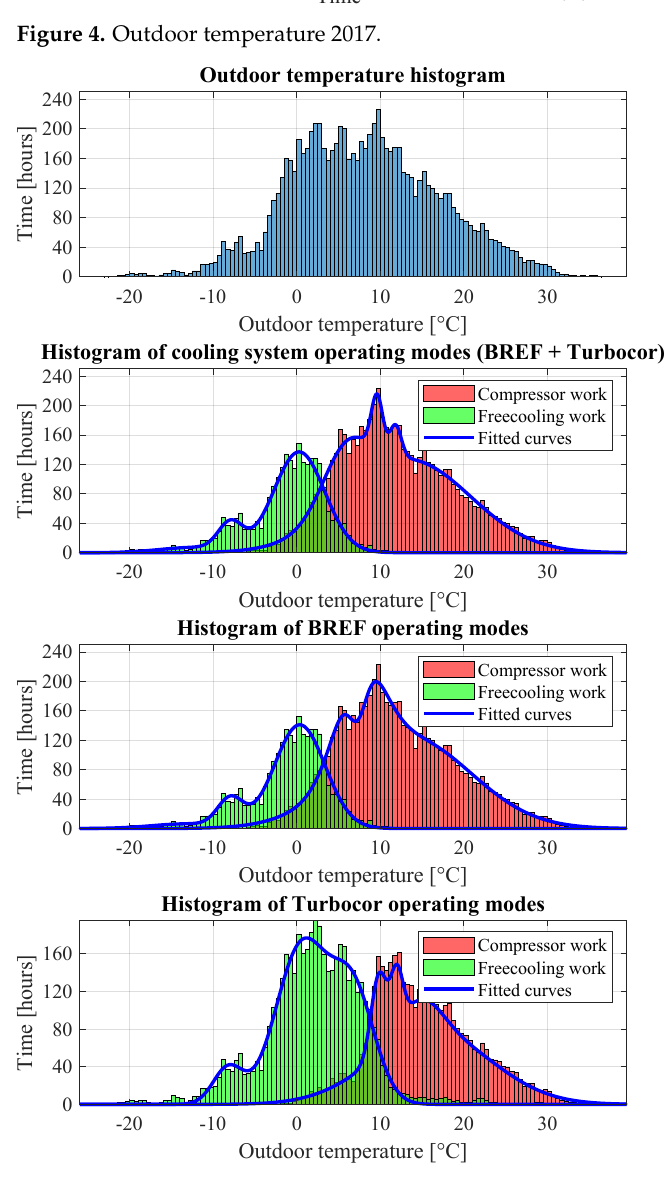
Figure 5. Histogram of temperature and operation modes generated on the basis of data collected in